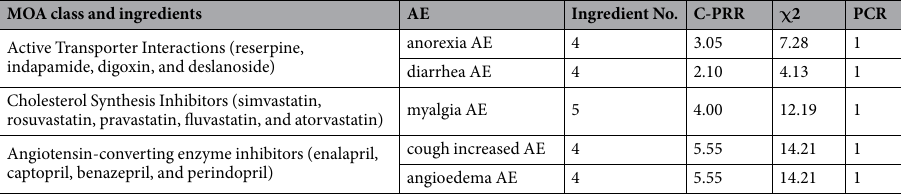
Table 2. CVD class effect based on CVD MOA